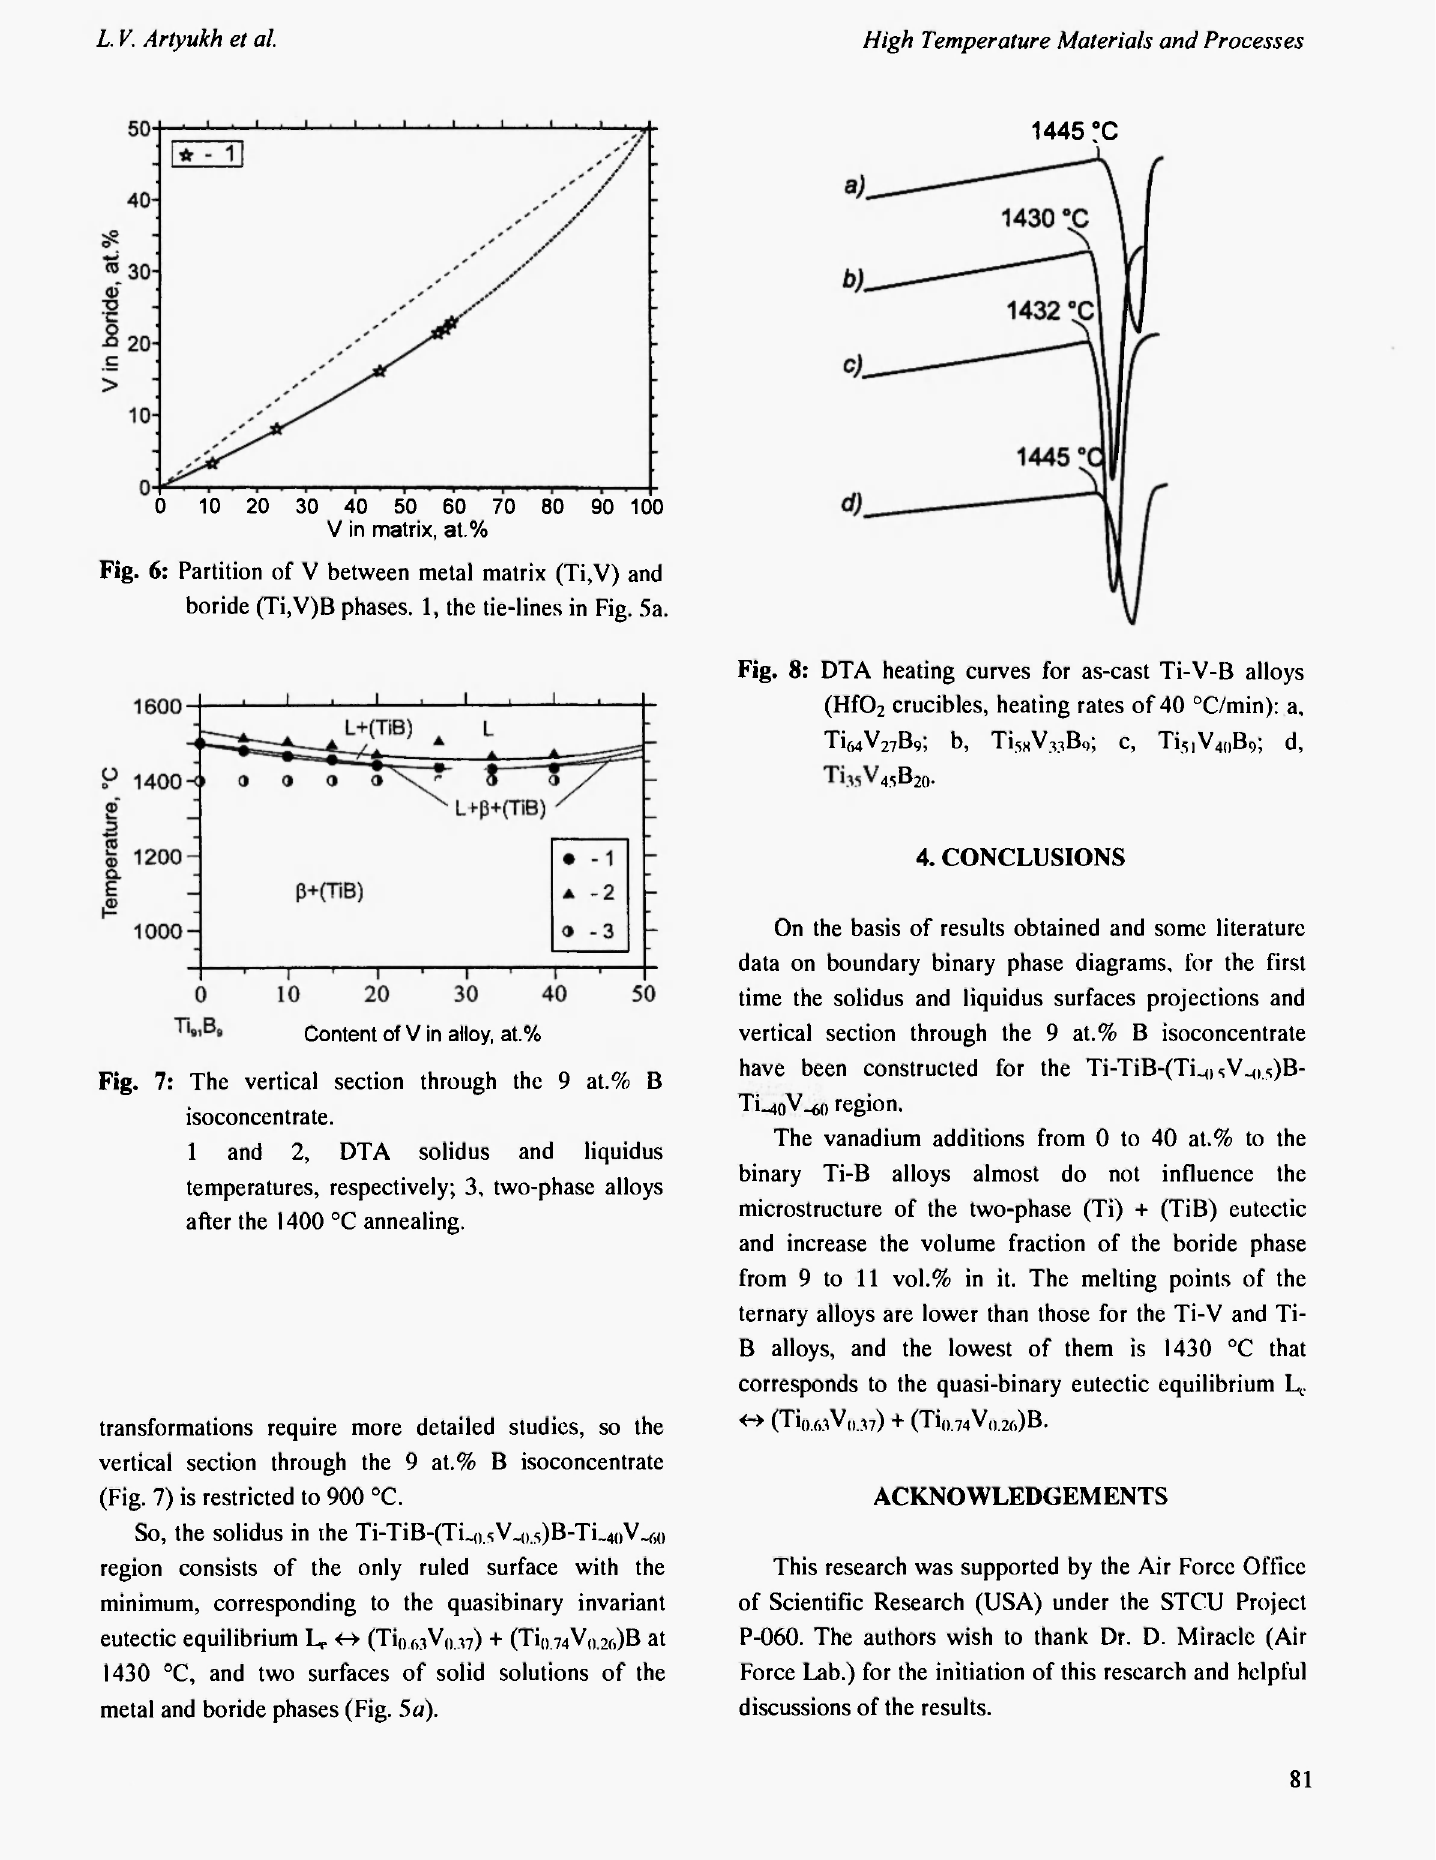
Fig. 6: Partition of V between metal matrix (Ti,V) and boride (Ti,V)B phases. 1, the tie-lines in Fig. 5a.